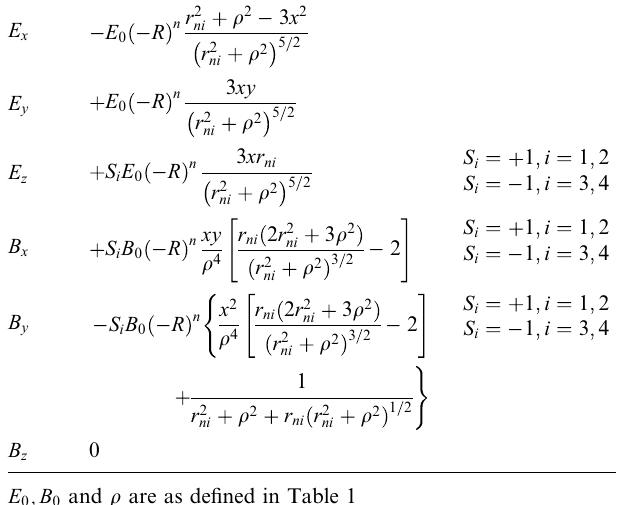
two to get the primary plus ‘thick layer’ contributions.